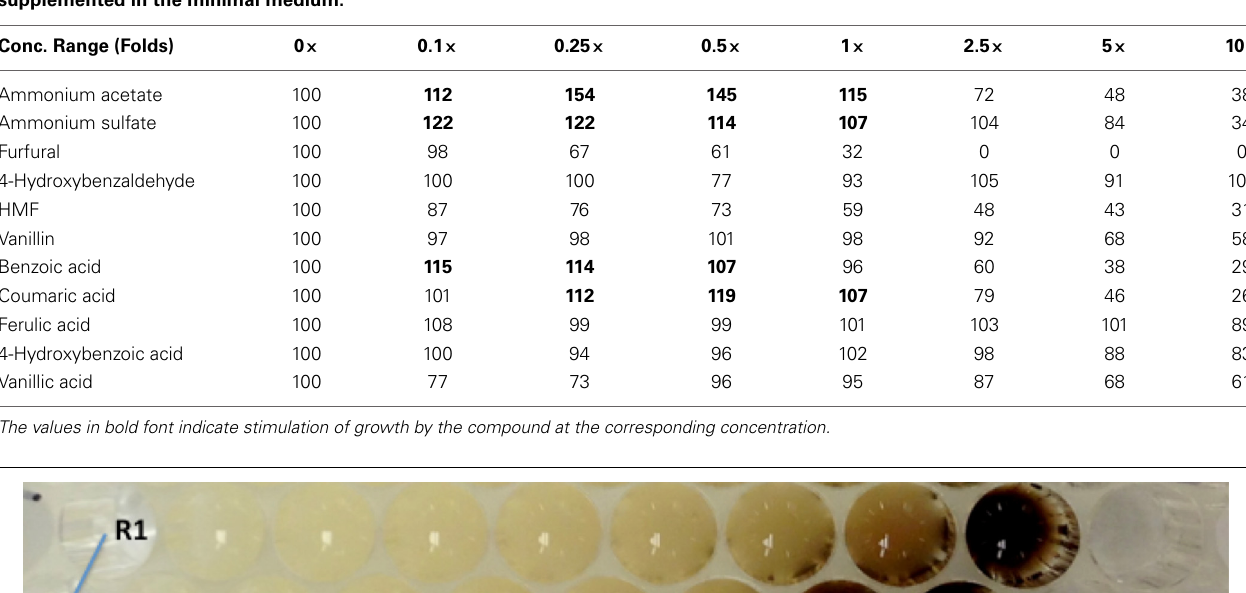
Table 6 | Response values of C. necator to 11 potentially toxic compounds identified in the saccharified slurry at different concentrations (mM) supplemented in the minimal